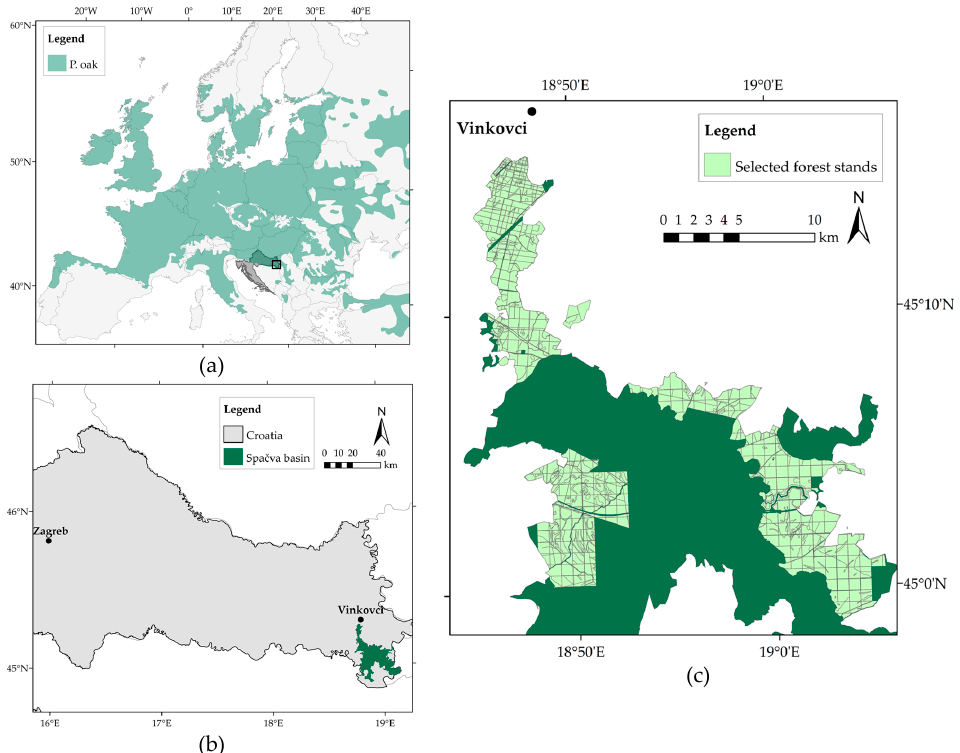
Figure 1. ( a ) Distribution map of pedunculate oak ( Quercus robur L.) in Europe [43]; ( b ) location of the Spa č va basin in Croatia; and ( c ) spatial distribution of 548 selected even-aged pedunculate oak stands within the Spa č va basin.